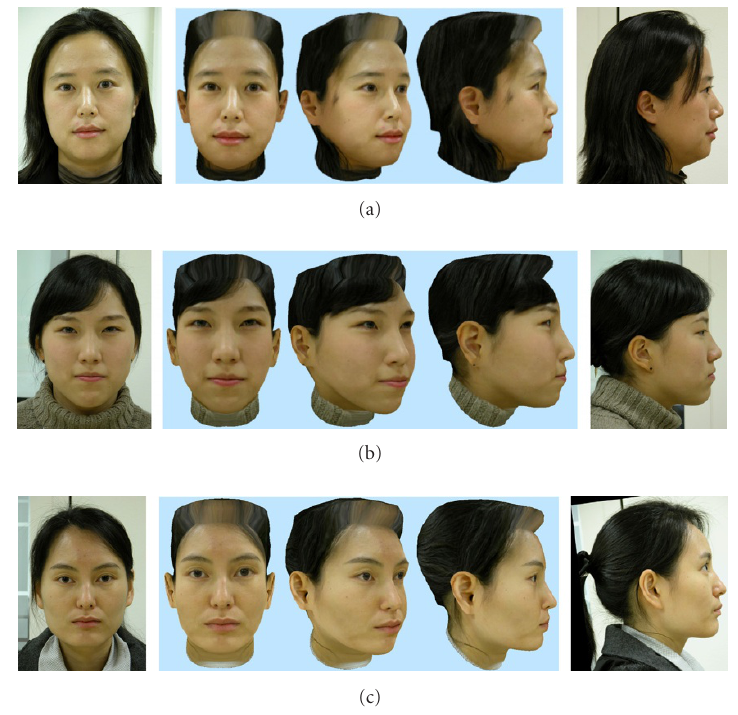
Figure 25: Final face models (Oriental women) generated by the proposed